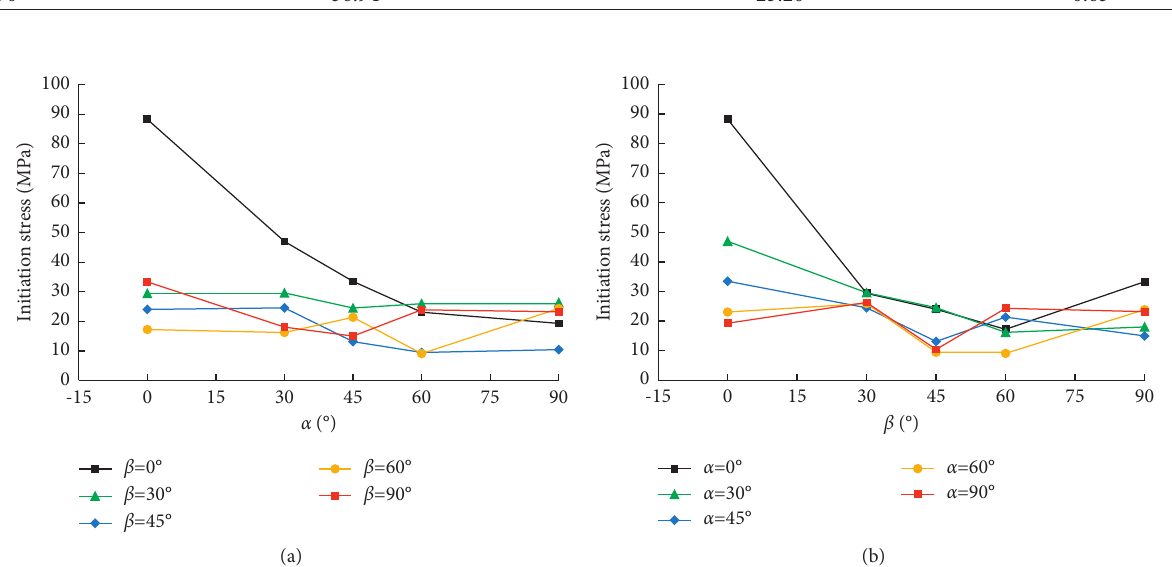
Figure 5: Variation lawofcrack initiation stress ofrock withcrossed cracks. (a)Relationshipbetween crack initiation stressand α .(b) Relationship between crack initiation stress and